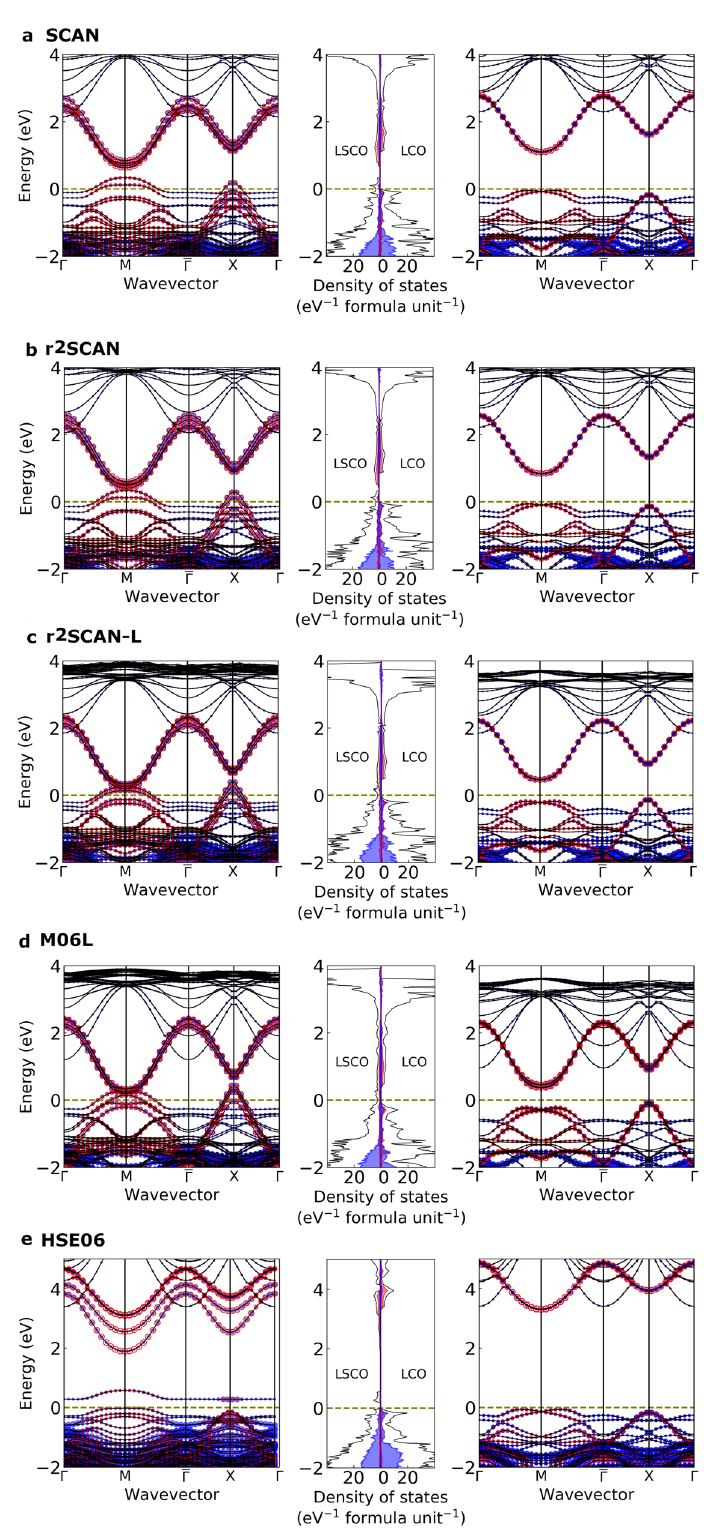
Fig. 6 Band structure and density of states (DOS) from various DFAs. Electronic band structure and density of states of LCO and LSCO in the LTO phase using a SCAN, b r 2 SCAN, c r 2 SCAN-L, d M06L, e HSE06. The contribution of Cu- d x 2 (cid:3) y 2 and O- p x + p y are marked by the red and blues shadings, respectively. The path followed by the dispersion in the Brillouin zone is shown in Fig. 1b.